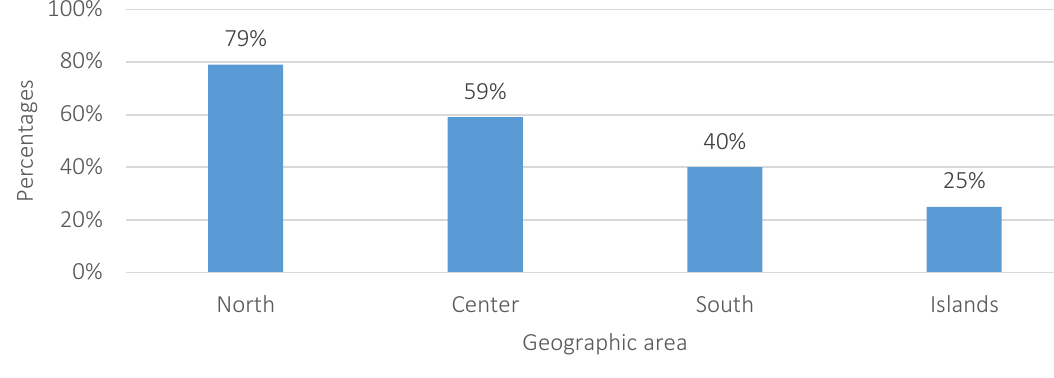
Figure 1. Insurance percentages by geographic area